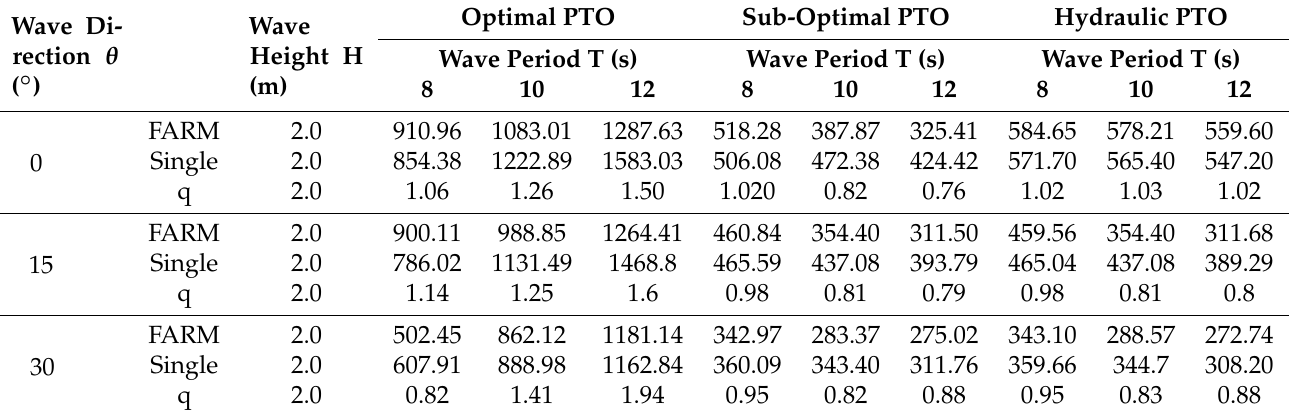
Table 4. Average power output for a farm of 21 OSWECs for a linear optimal, a linear sub-optimal and a hydraulic PTO